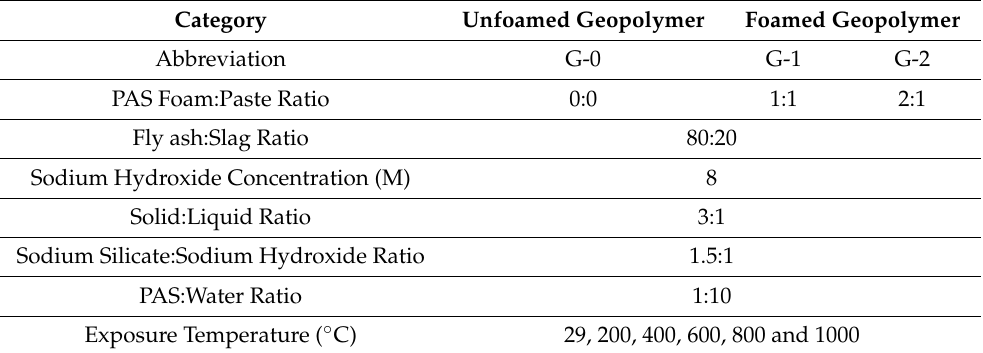
Table 2. Details of sample